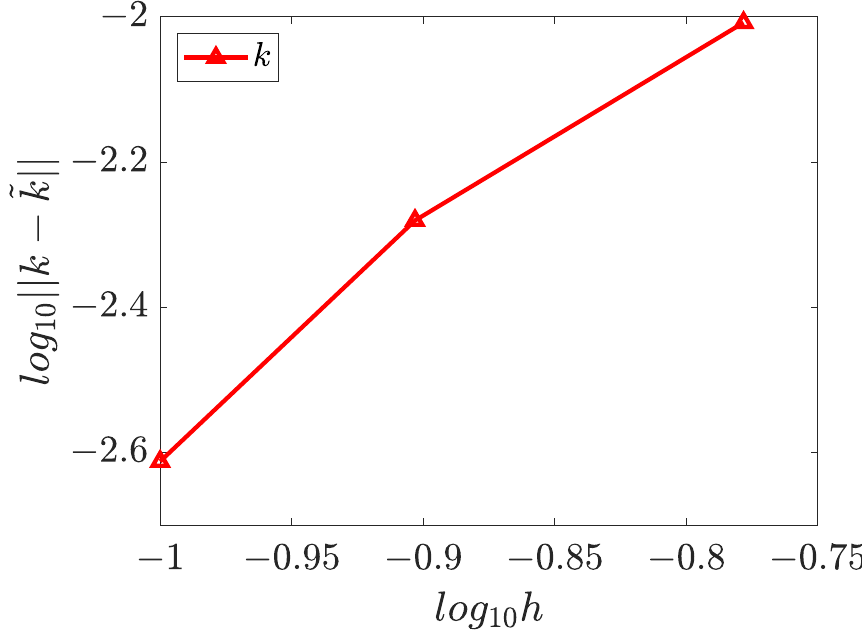
Figure 24. Convergence of wave number for the 3D parameter identification problem in cubic do- main.